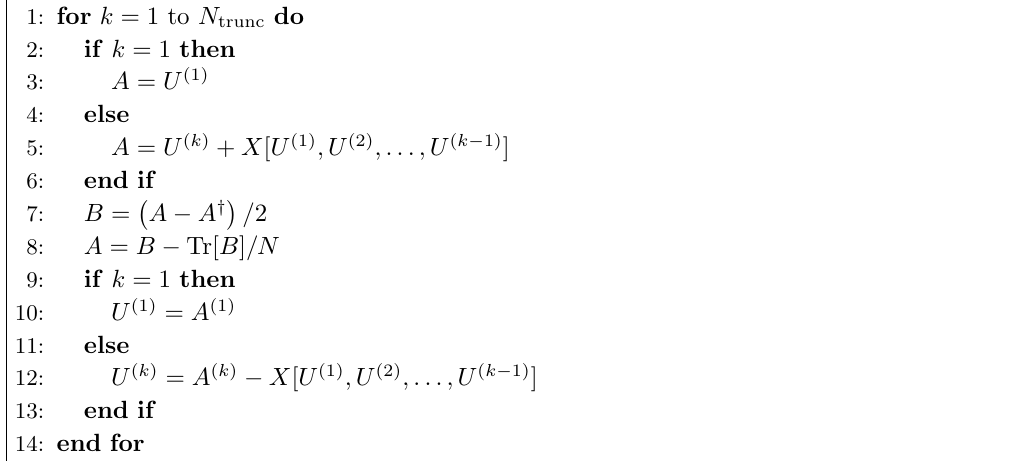
Algorithm 4. Perturbative reunitarization algorithm for a SU( N ) matrix. A and B are working